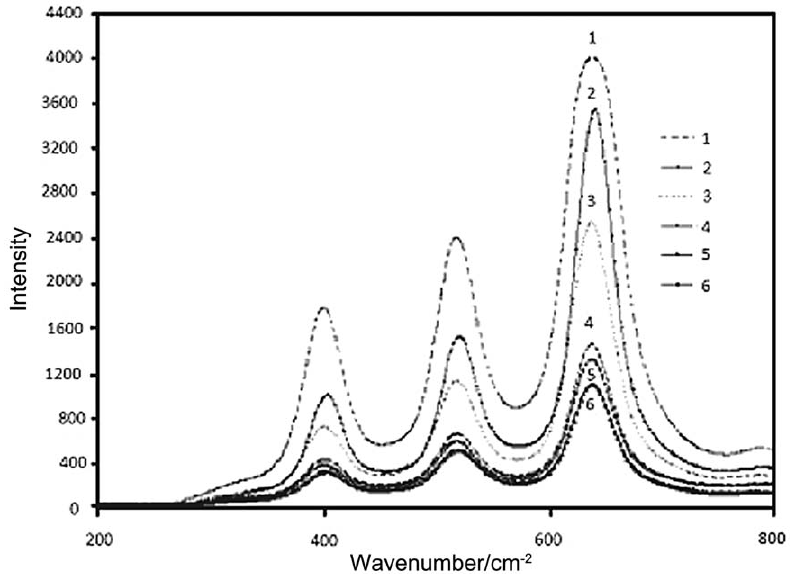
Figure 3. Comparison of the Raman spectrum of the samples after calcinations at 600 6 C: sample 1, sample 2, sample 3, sample 4, sample 5, sample 6.